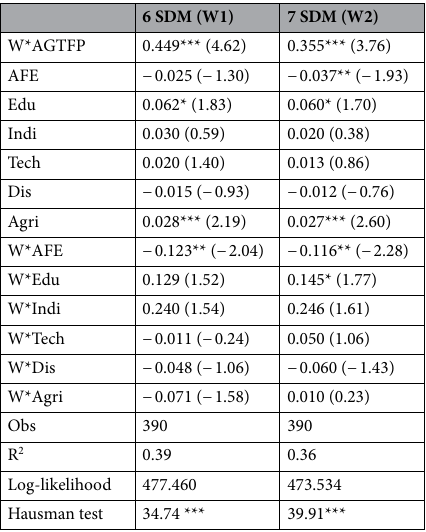
Table 4. Regression results of AFE on AGTFP. *, **, *** indicate significance at the 10%, 5% and 1% level. For the estimated coefficients, the standard errors are in parentheses.